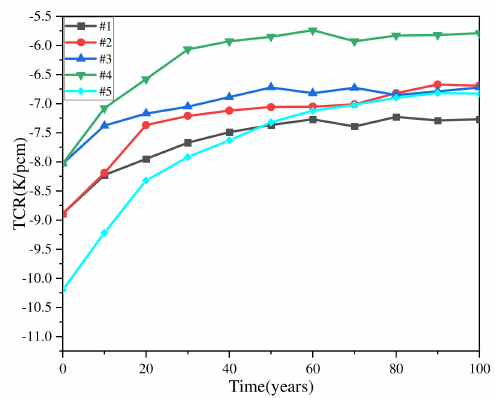
Figure 13. Evolution of TCR for different